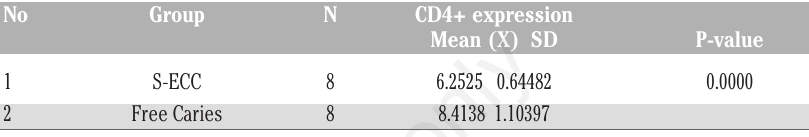
Table 1. Mean and standard deviation of the expression of T lymphocytes (CD4 +) after 24-hour incubation were analyzed by flow cytometry test and statistical test